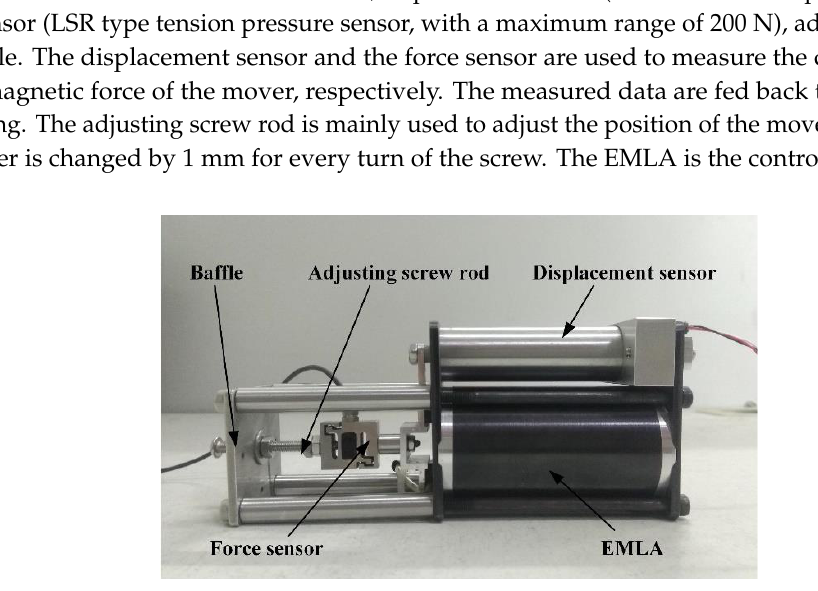
Figure 12. Dynamic viscosity distribution map of the MR fluid: ( a ) I = 1 A; ( b ) I = 2.5 A.